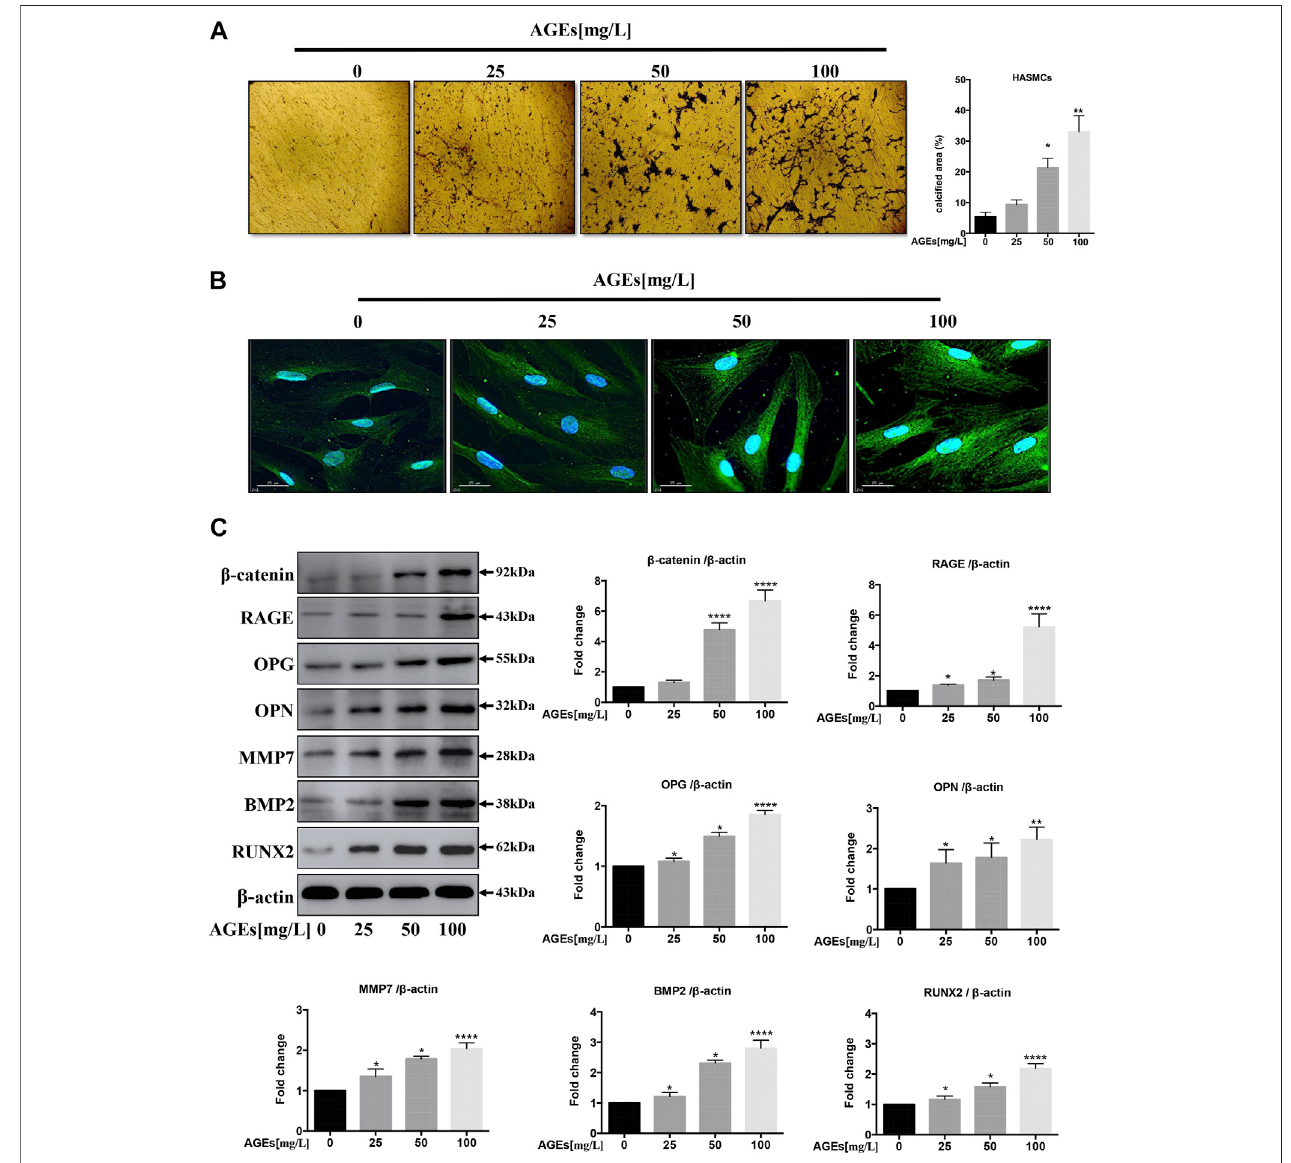
FIGURE 1 | AGEs induce calci fi cation in HASMCs. (A) Dose-dependent study of AGEs-induced calci fi cation in HASMCs at AGEs concentrations from 0 to 100 mg/L. Von Kossa staining (black) in HASMCs after AGEs treatment for 2 weeks. scale bar (cid:2) 100 µm ( × 10). (B) Immuno fl uorescence staining of calci fi cation-related proteins with24 h ’ AGEs treatment atindicatedconcentrations. Thegreen GFPsignal representsthecalci fi ed protein OPN.Theblue DAPIsignalrepresentsthenuclear region,scalebar,25 µm. (C) WesternblotanalysisoftheexpressionofRAGEandothercalci fi cation-relatedproteins( β -catenin,OPG,OPN,MMP7,BMP2,Runx2) with24 h ’ treatment. Dataare presented asthe fold changecompared withthe control group. Each point represents themean ± SD ( n (cid:2) 3/group); *p < 0.05, ** p < 0.01, *** p < 0.001.